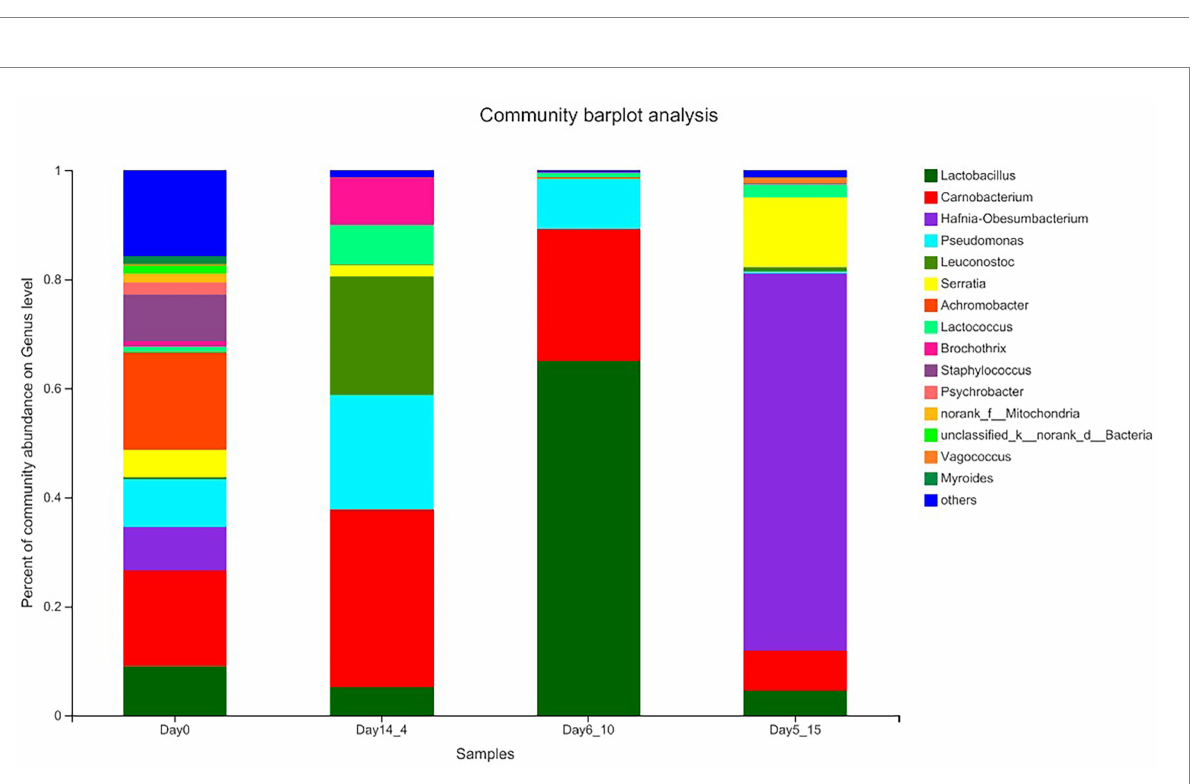
FIGURE 3 Relative abundance (%) of the top bacterial genera (Genus level) found on beef samples aging 14 days at 4 ° C, aging 6 days at 10 ° C, and aging 5 days at 15 ° C.